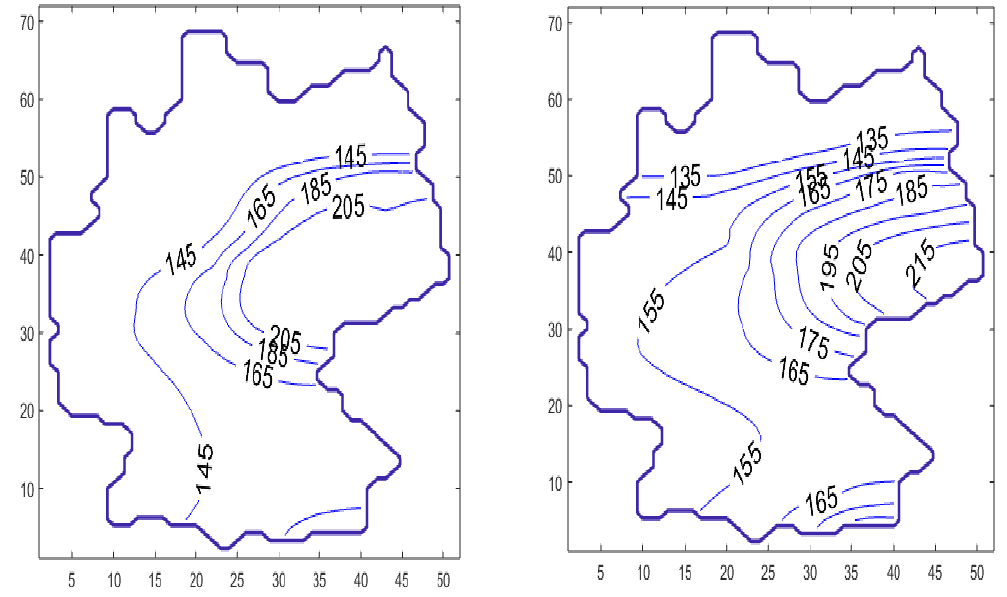
Figure 5. Contour lines of s at t = 15days ( left panel ), t = 125days ( right panel ), with the source-sink function q = 0, and the coefficient γ = 250